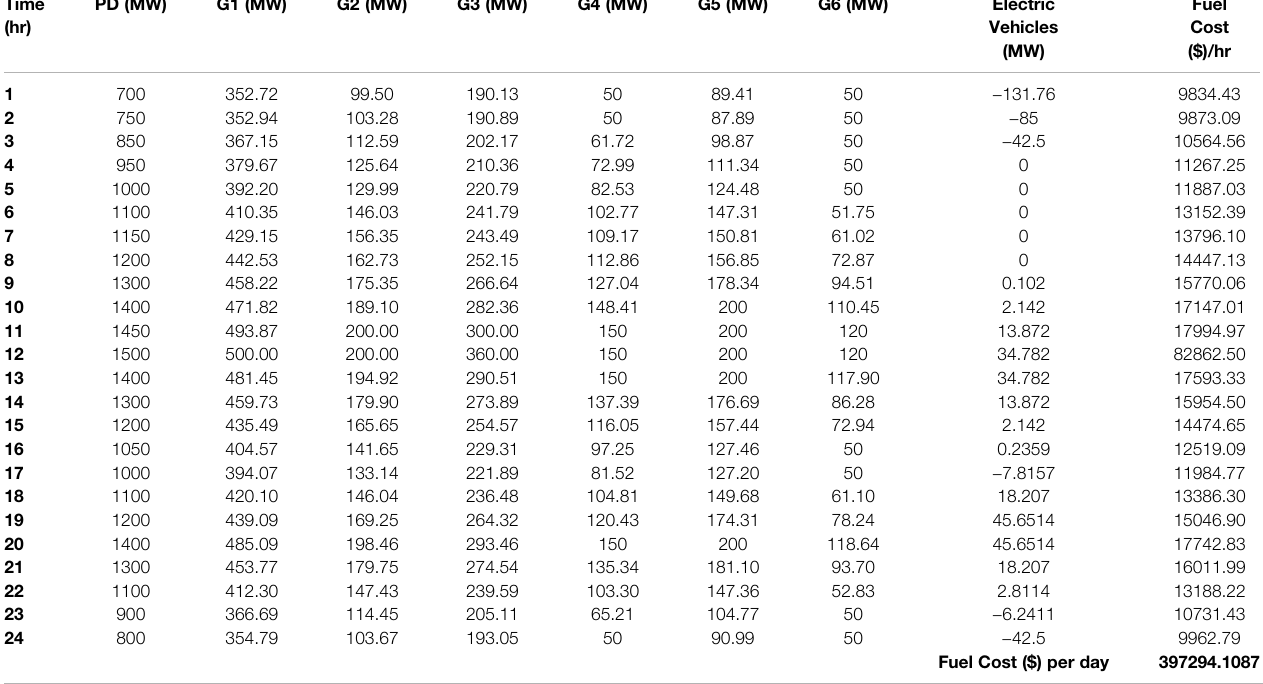
TABLE 1 | 6-unit generator Dynamic Load Dispatch with EVs (without valve point loading effect without losses) using Chimp optimizer Algorithm. Time